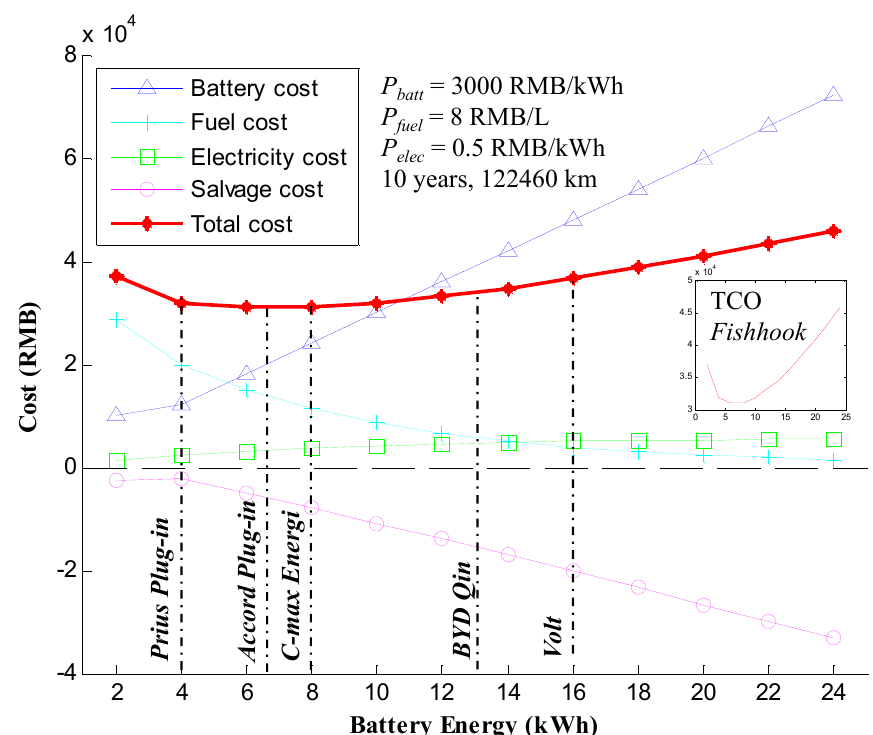
Figure 5. TCO and sub-costs curves for the baseline